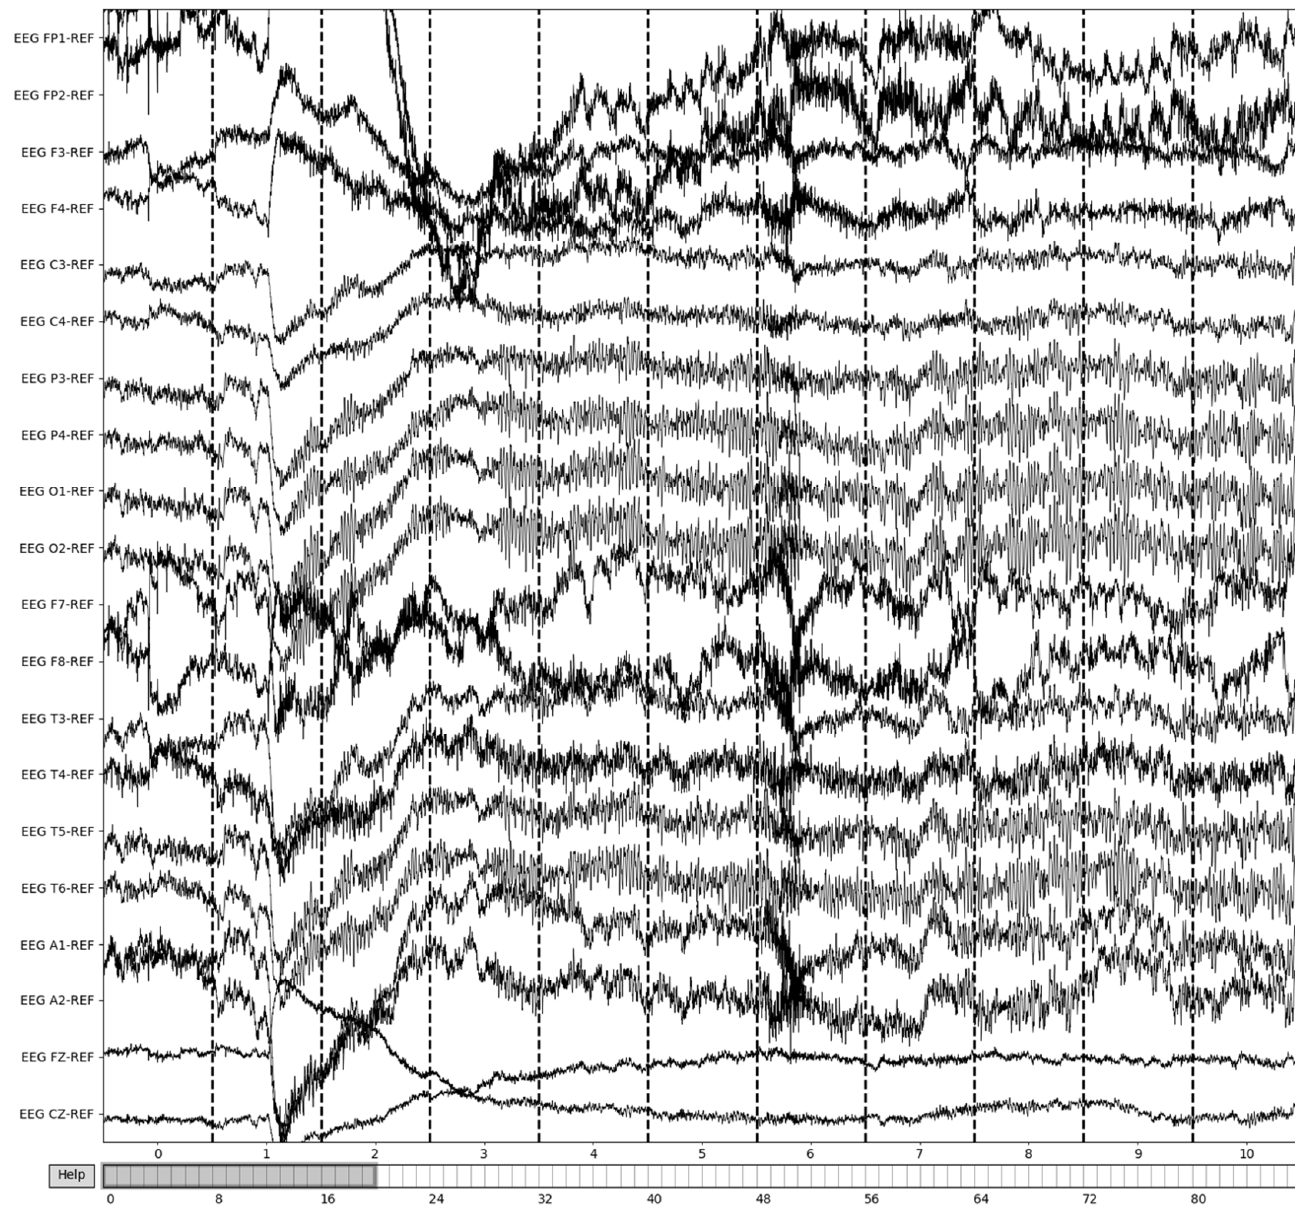
Figure 6. Creation of 3-second epochs of recordings.